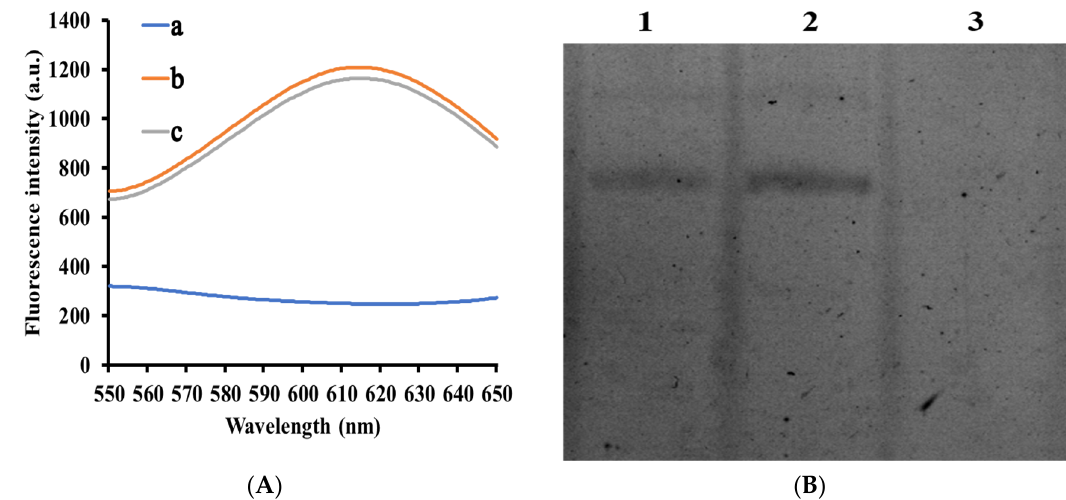
Figure 1. Investigation of the feasibility of the sensing strategy. ( A ) The fluorescence emission spectra of CuNPs under different conditions. Curve a: T30 + ALP + Exo I + Cu 2+ + sodium ascorbate (T30, 2 µM; ALP, 500 U/L; Exo I, 40 U/mL; Cu 2+ , 200 µM; sodium ascorbate, 5 mM); curve b: without Exo I; curve c: without ALP. ( B ) Urea-PAGE with silver staining analysis under different conditions. Lane 1: T30+Exo I (T30, 2 µM; Exo I, 40 U/mL); lane 2: T30 (T30, 2 µM); lane 3: T30+ALP+Exo I (T30, 2 µM; ALP, 500 U/L; Exo I, 40 U/mL).